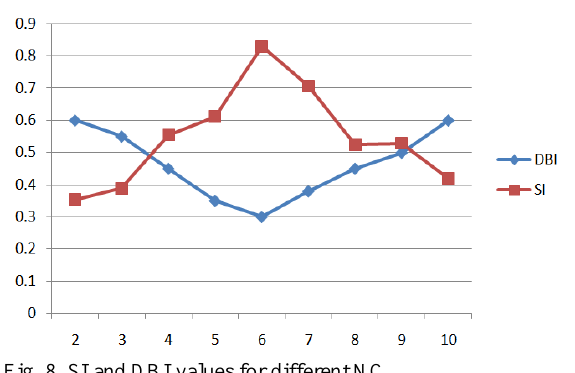
Fig. 8. SI and DBI values for different